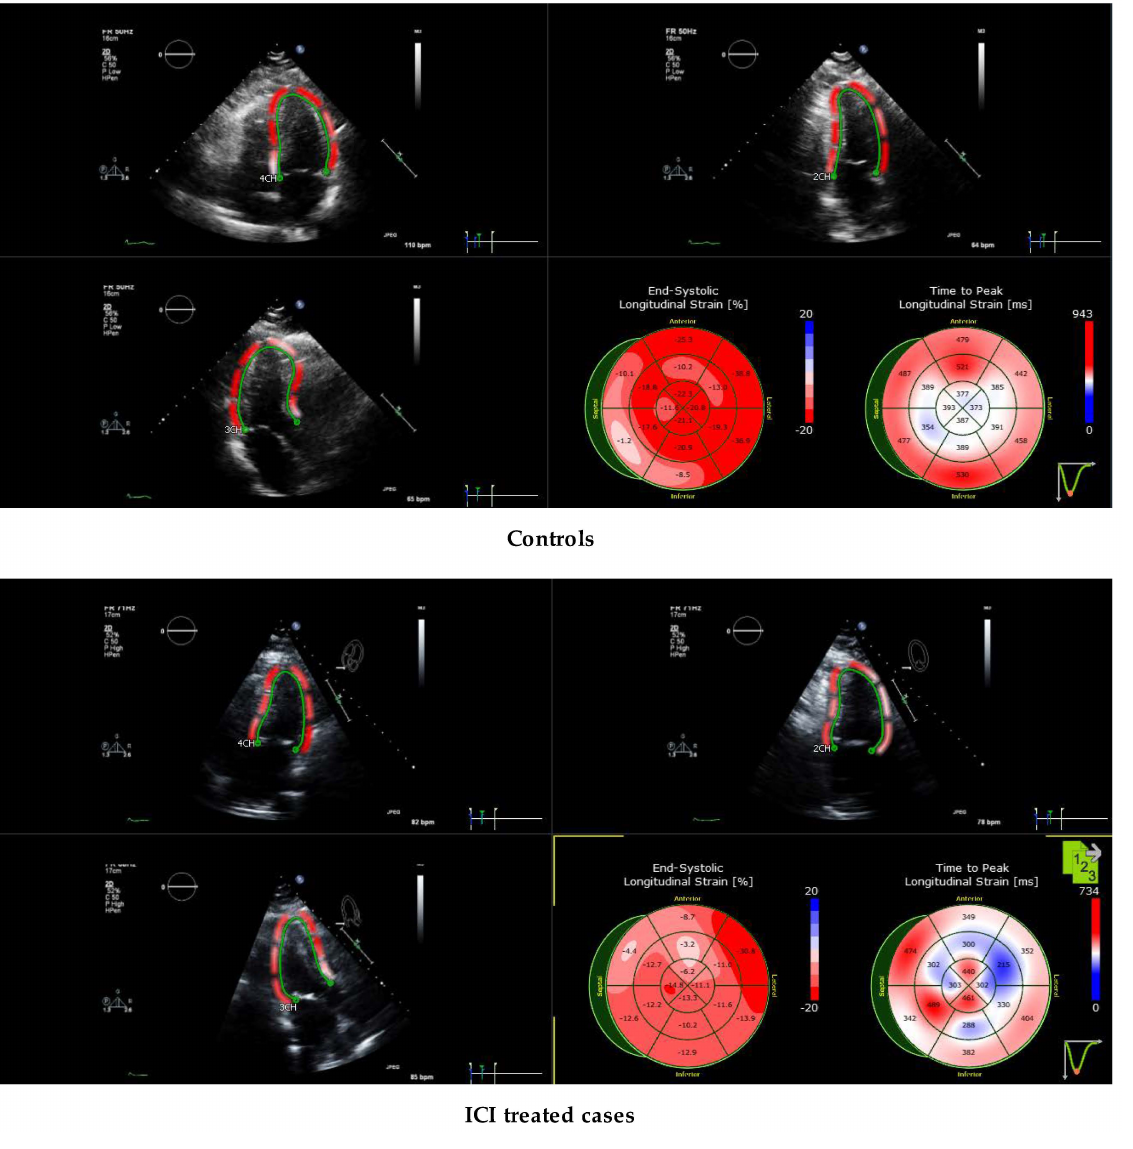
Figure 1. Left ventricular (LV) longitudinal strain imaging of immune checkpoint inhibitor (ICI)-induced cardiomyopathy using speckle tracking echocardiography. The midventricular and apical segments are relatively